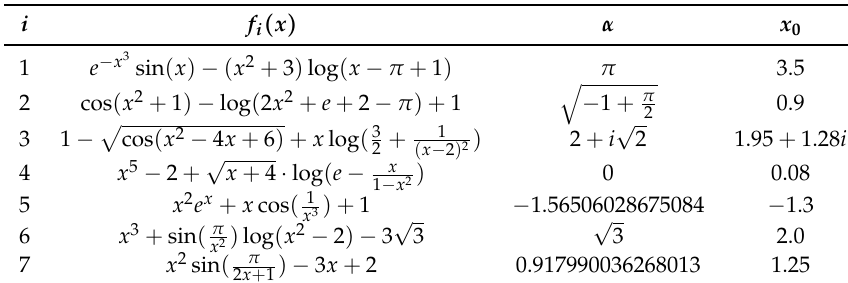
Table 3. Additional test functions f i ( x ) with zeros α and initial values x 0